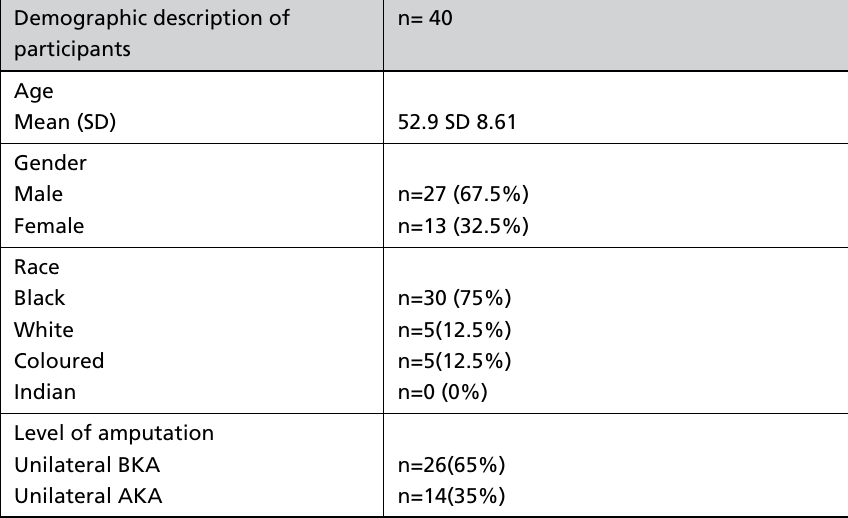
Table 1: Demographic description of participants (n =40)